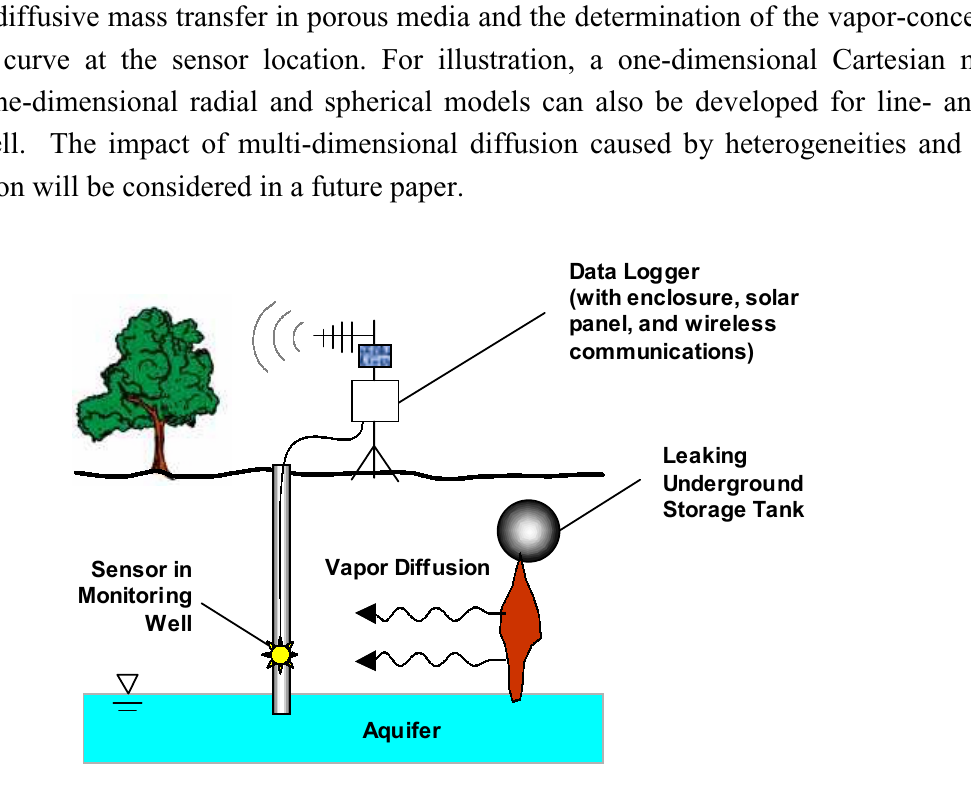
Figure 5 . Monitoring for contaminant leaks from an underground storage tank in the unsaturated